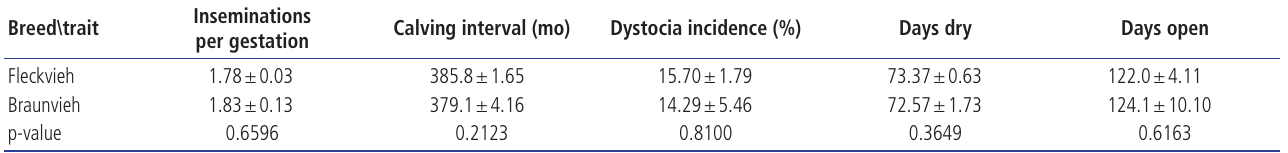
Table 2. Averages (±SEM) for reproduction efficiency traits in Fleckvieh and Braunvieh cows Breed\trait